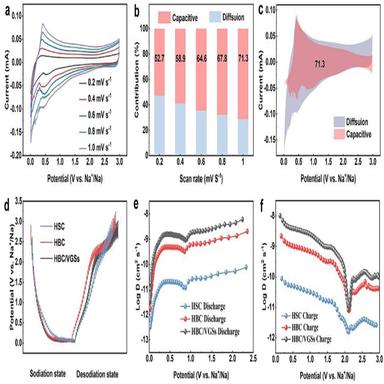
Kinetic analyses of the HBC/VGSs electrode: a) CV curves at different scan rates, b) the proportions of capacitive and diffusion contributions at varying scan rates, c) the proportions of capacitive contributions at 1 mV s1 , d) GITT curves and e-f) the calculated Na+ diffusion coefficient during the third discharging and charging process.